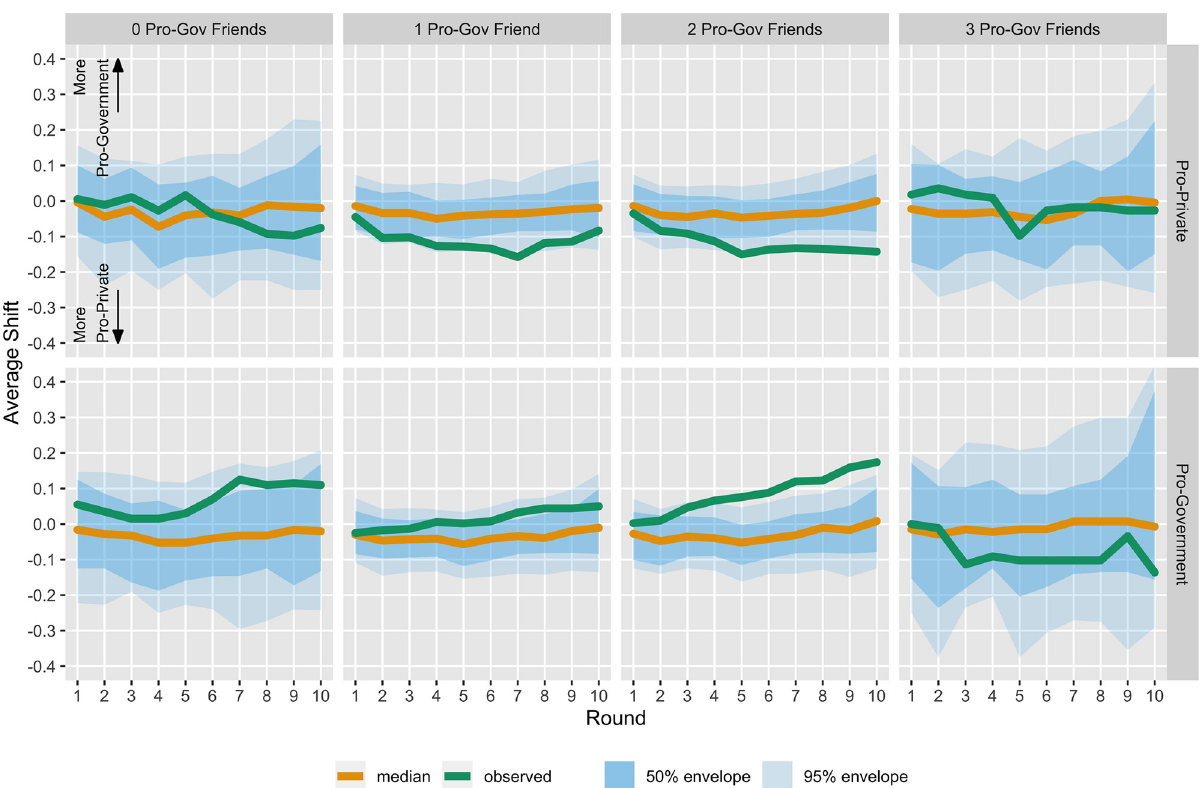
Fig 6. Average shift from baseline by official and social information treatment groups. The green line in the upper left panel displays the progression across the 10 rounds of the average score shift from baseline (time 0), for those both assigned to view pro-private messages and for whom none of their three selected friends assigned to view pro-government funding messages. Negative score shifts indicate that on average participants in this group express opinions that are more pro-private than they had at baseline. The orange lines are median (most usual) progressions and blue bands are 50 and 95 percentile envelopes constructed via the permutation reference distributions for these same progressions. The other panels display the same attributes for the other five strata defined by the cross-classification of direct and friend treatment assignments.